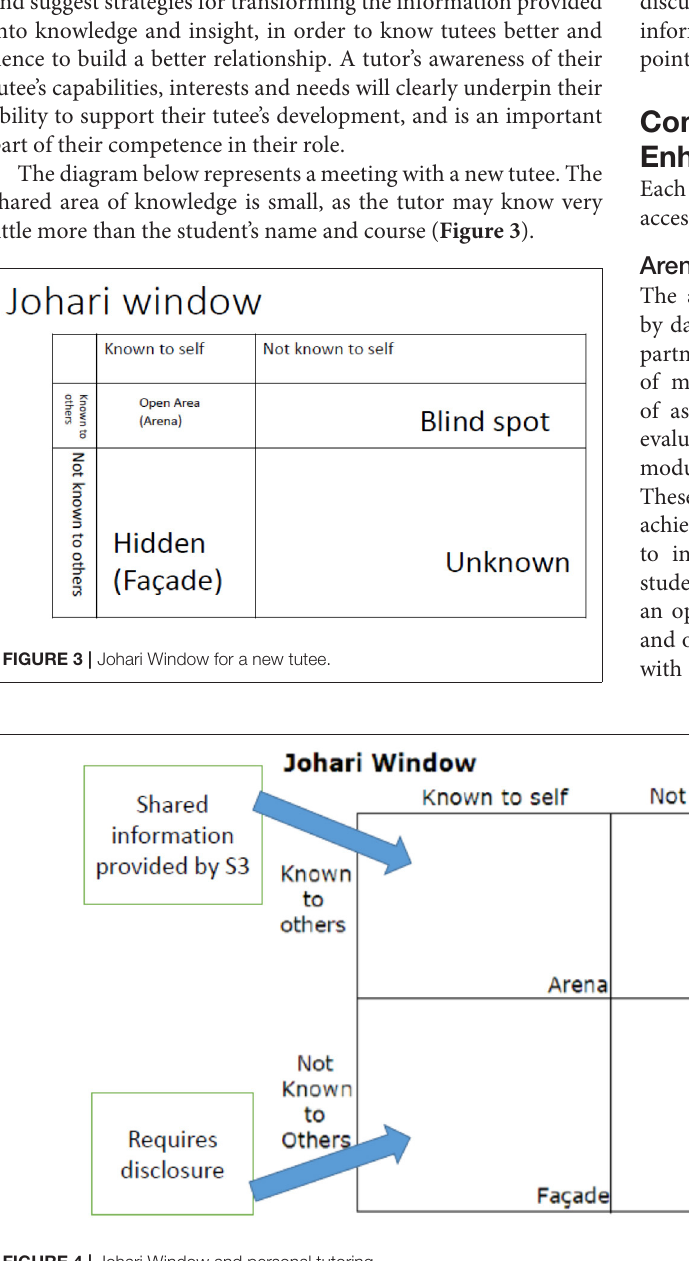
FIGURE 4 | Johari Window and personal